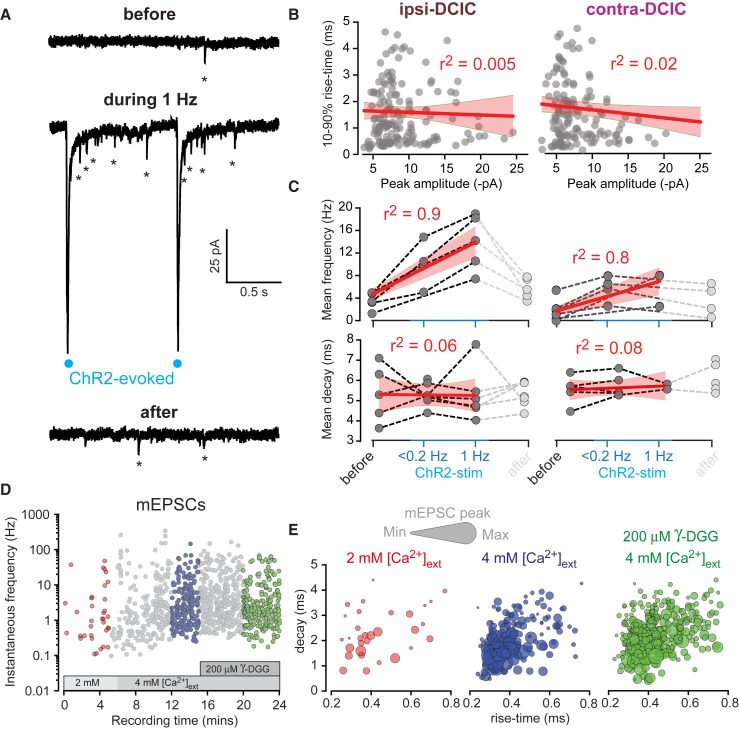
Light Stimulation of ChR2-Expressing CC Terminals Leads to a Rate-Dependent Increase in Asynchronous Quantal Release(A) Results from a typical voltage-clamp experiment recorded in the presence of TTX and 4-AP, illustrating three current traces from the same ipsi-DCIC neuron obtained before, during, and after 1 Hz stimulation of ChR2-expressing CC terminals. Blue circles mark the timing of 1 ms light pulses delivered through the imaging objective. Asterisks indicate the incidence of spontaneously occurring mEPSCs.(B) Scatterplots of mEPSC peak amplitudes against 10%–90% rise times for recordings made from IC neurons in the ipsi-DCIC and contra-DCIC. Filled gray circles are values for each mEPSC, and the solid red line is the result of a linear regression analysis of all data, with the shaded areas depicting the 5% and 95% confidence limits for these fits. The very low r2 values indicate no relationship between peak amplitude and rise time.(C) Scatterplots of mEPSC mean frequency recorded from IC neurons before, during, and after ChR2 stimulation. The solid red line is the result of a linear regression analysis, and the shaded areas are the 5% and 95% confidence limits for these fits. The high r2 values indicate that a large proportion of the data is described by a simple linear relationship. Light gray symbols are the recovery values for each IC neuron. These values were not used for the regression analysis. In addition, we were not able to analyze the frequency of mEPSCs at all stimulation frequencies in every cell. The same analysis was repeated for the weighted decay values obtained for the mEPSC populations, demonstrating little change in the decay of the mEPSCs before, during, and after optogenetic stimulation.(D) Scatterplot of mEPSC instantaneous frequency during an experiment in which the external Ca2+ concentration was raised and the low-affinity glutamate antagonist γ-DGG was applied. In this recording, the mEPSC frequency increased from a median value of 1.08 Hz (red symbols) to 2.43 Hz (blue symbols) in 4 mM Ca2+. The median mEPSC frequency did not change in 200 μM γ-DGG (green symbols).(E) Scatterplots of 10%–90% rise time and weighted decay estimates illustrating the peak amplitude of each mEPSC with different-sized bubbles. Note the similar distributions for the different epochs highlighted in (D).